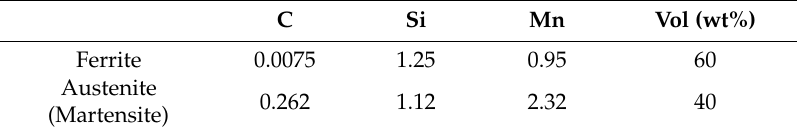
Table 2. Composition and volume fraction of specimens at 1058 K (wt%).